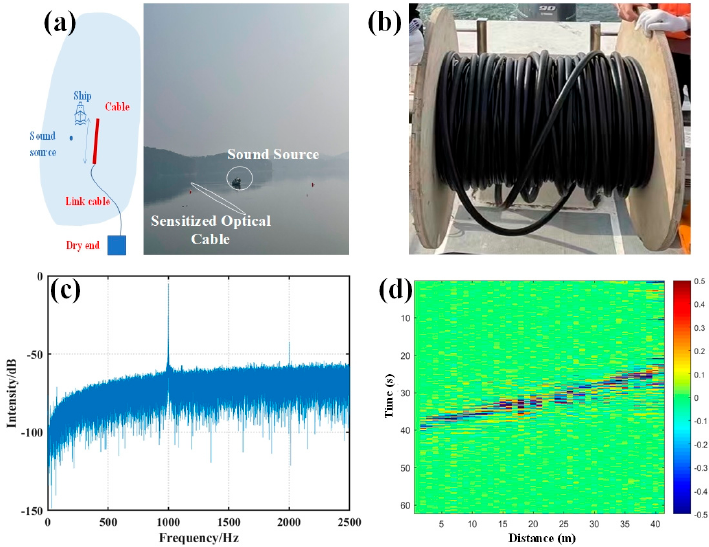
Figure 23. The underwater acoustic test: ( a ) the setup for the field test; ( b ) picture of the sensitized optical cable; ( c ) the static test results for the sound source; ( d ) motion trajectory tracking of the sound source.